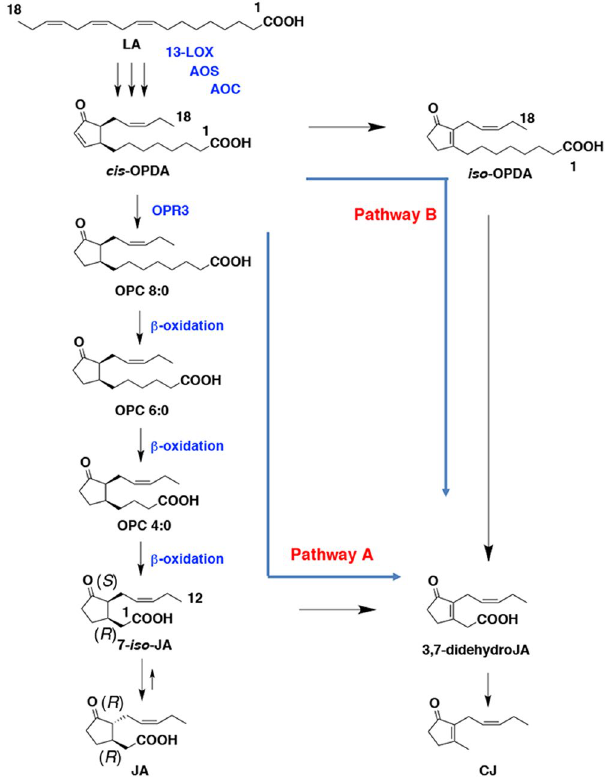
Figure 1. Biosynthetic pathway to give CJ and JA. LA: α -linolenic acid, OPDA: 12-oxo-phytodienoic acid, OPC 8:0: 3-oxo-2-(2 ′ -[ Z ]-pentenyl)-cyclopentane-1-octanoic acid, OPC 6:0: 3-oxo-2-(2 ′ -[ Z ]-pentenyl)- cyclopentane-1-hexanoic acid, OPC 4:0: 3-oxo-2-(2 ′ -[ Z ]-pentenyl)-cyclopentane-1-butanoic acid (OPC 4:0). 13-LOX: 13-lipoxygenase, AOS: alene oxide synthase, AOC: alene oxide cyclase, OPR3: 12-oxophytodienoate reductase